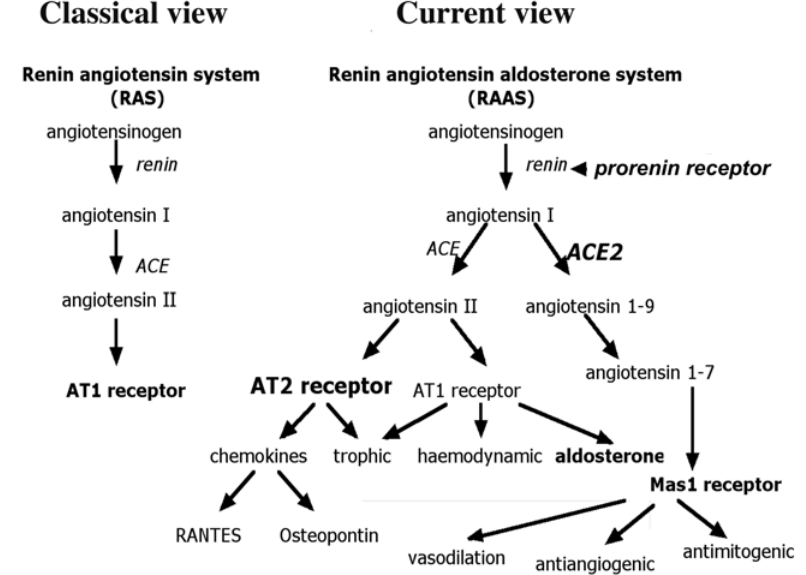
FIGURE 1. The evolving view of the